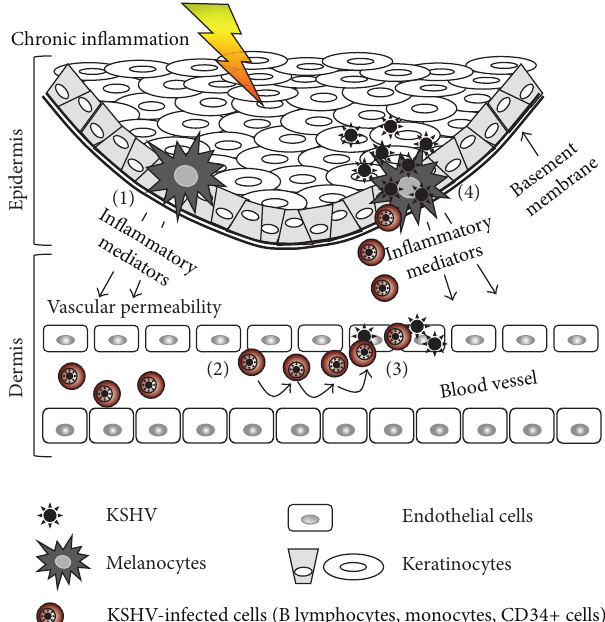
Figure 9: Hypothetical model of immunophysiologic mechanisms that control transmission of KSHV from latently infected cellular reservoirs to cells within skin. (1) Chronic activation of NF- 𝜅 B in the skin induces expression of adhesion molecules on the surfaces of endothelialcells,increasedvascularpermeability,andsecretionofinflammatorycytokinesandchemokinesbymelanocytesandotherresident cells of the skin, (2) recruitment of immune cells and other KSHV-infected monocytes to the vascular endothelium, and (3) extravasation of infected cells from the blood vessels into the underlying dermis, where virus may be transmitted to vascular endothelial cells through cell-to-cell contact or other mechanisms. (4) Accumulation of cell-free and KSHV-infected cells at the superficial dermis, where they interact with and infect resident melanocytes and keratinocytes in the basal